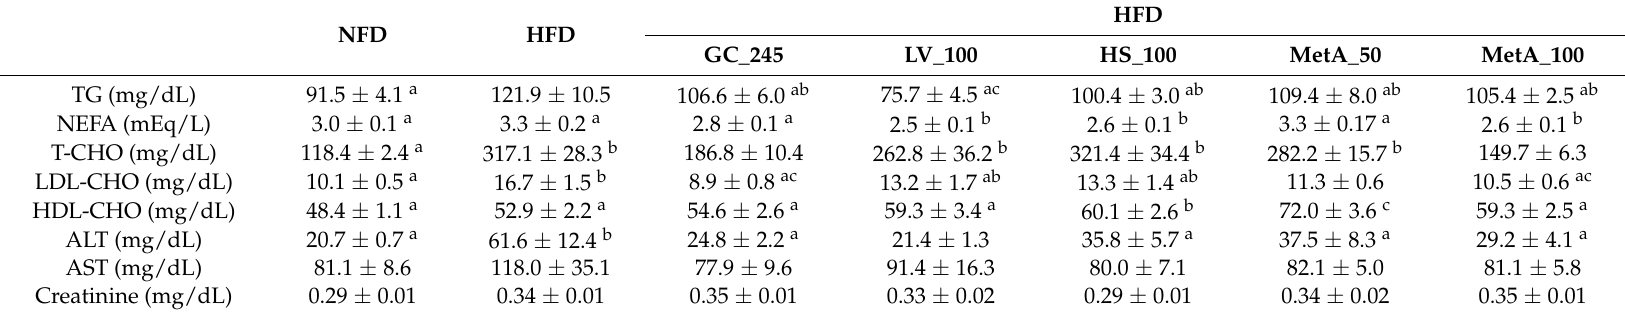
Table 2. Effect of LV, HS, and the MetA-mixed extract of LV and HS on biochemistry parameters in serum and liver tissue of HFD-induced obese